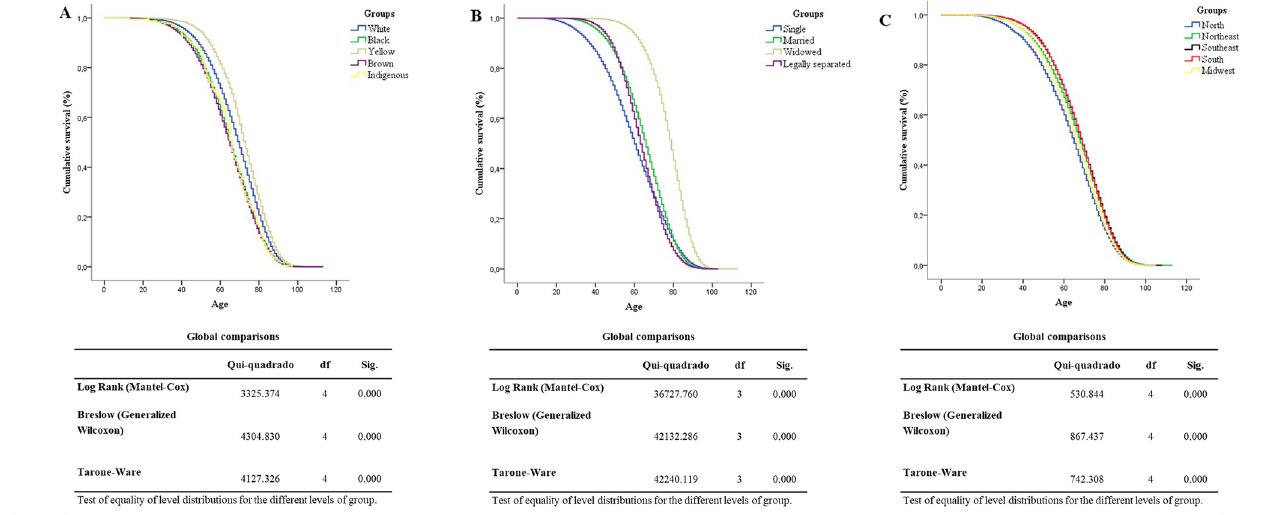
Fig 5. Survival curves among the different racial classification groups (A), marital status (B) and geographic regions (C) using Kaplan-Meier plots.